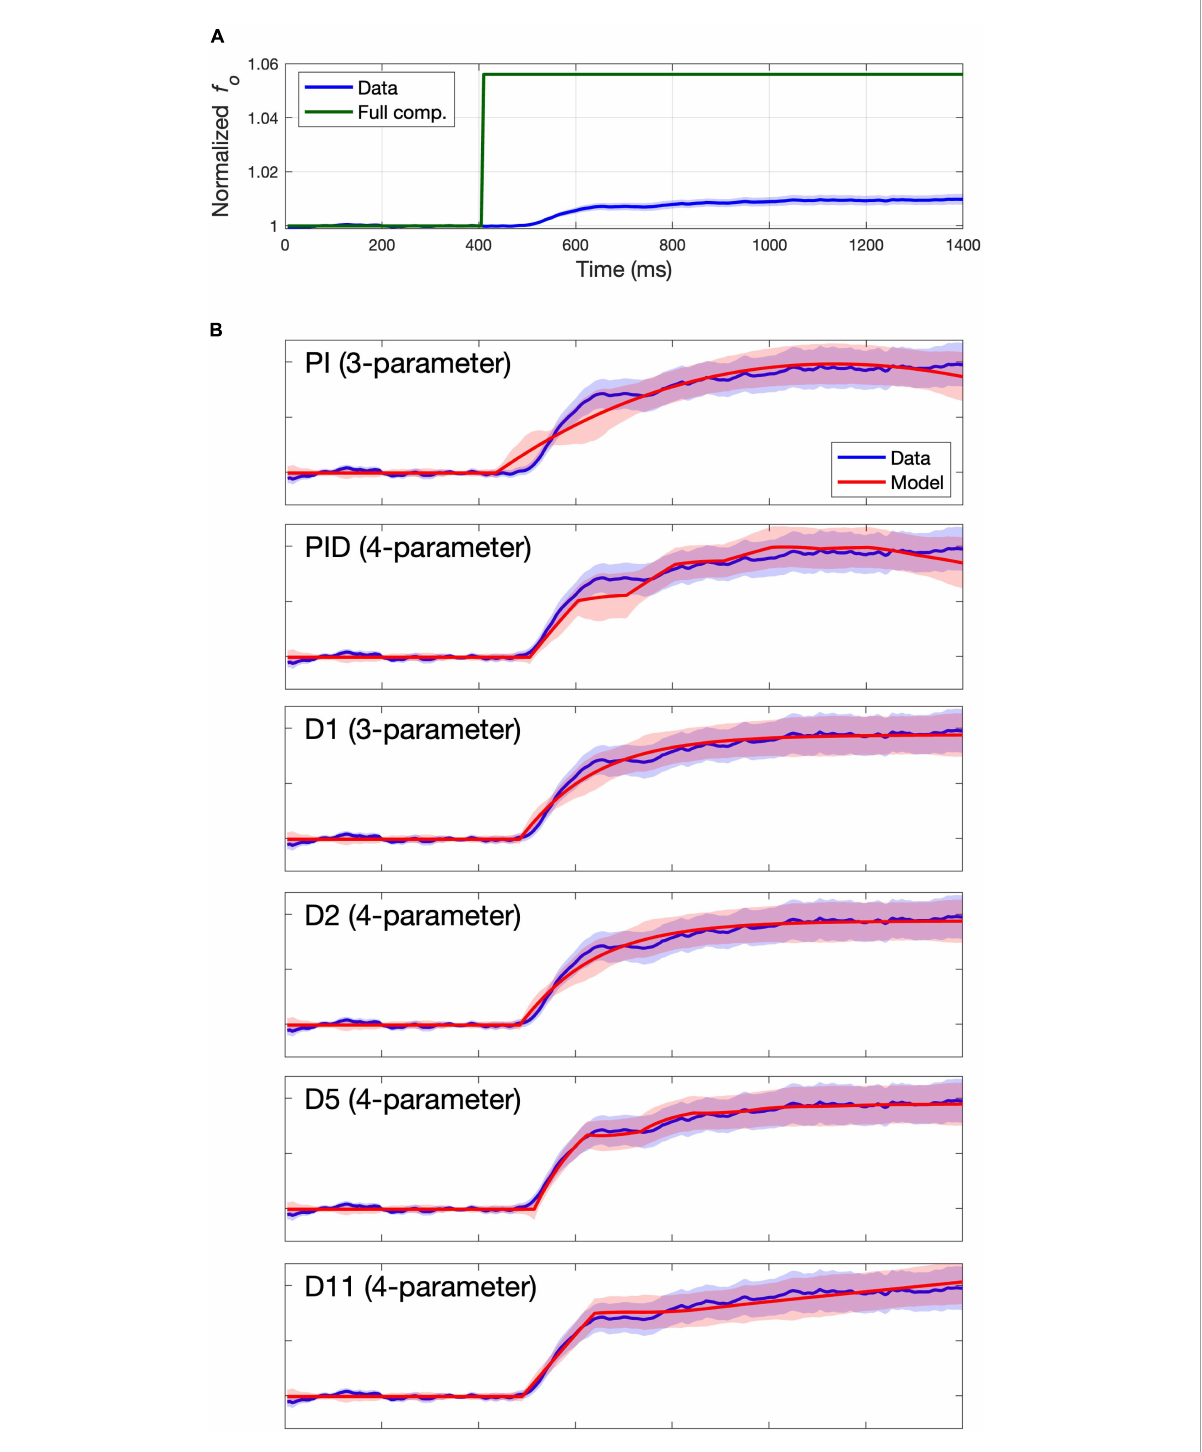
FIGURE3 Group mean data and model fits for Study 2. Group mean data and standard error of the mean are shown with a blue line and shading. (A) Group mean data shown relative to full compensation in green. Full compensation is the inverse of the perturbation magnitude and illustrates what 100% compensation would look like. (B) Group mean data shown relative to model fit (red line) and standard error of the model fit (red shading) for models providing best fits to the group mean